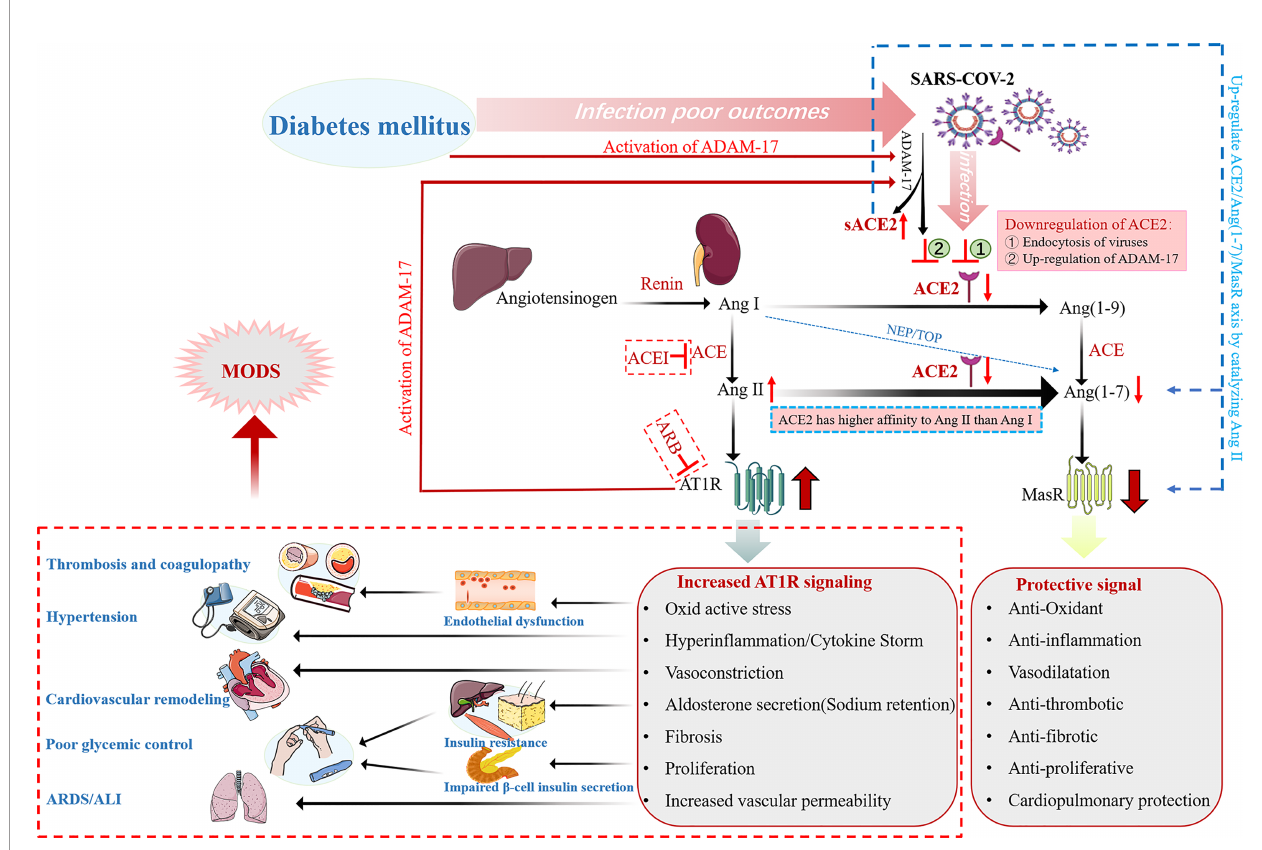
FIGURE 1 | Schematic representation of the alterations of the renin angiotensin aldosterone system (RAAS) in diabetic patients with COVID-19. ADAM-17 is activated in diabetic patients, therefore both DM and SARS-CoV-2 infection downregulate membrane-bound ACE2 in diabetes mellitus patients with COVID-19. ACE2 has a higher af fi nity for Ang II than Ang I. Therefore, down-regulation of ACE2 leads to Ang II accumulation and decreased Ang (1-7) levels. In turn, accumulation of Ang II activates ADAM-17, resulting in increased sACE2 shedding and a further decrease in membrane-bound ACE2. Thus, the protective signal mediated by ACE2/Ang (1-7) axis is down-regulated, and the detrimental signal mediated by Ang II/AT1R axis is up-regulated, resulting in multiple organ damage effects and even multiple organ